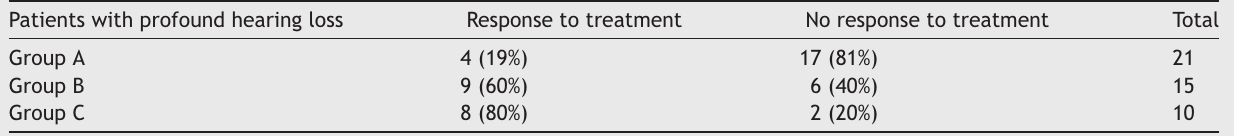
Response to the treatment in patients with profound hearing loss. Patients with profound hearing loss Response to